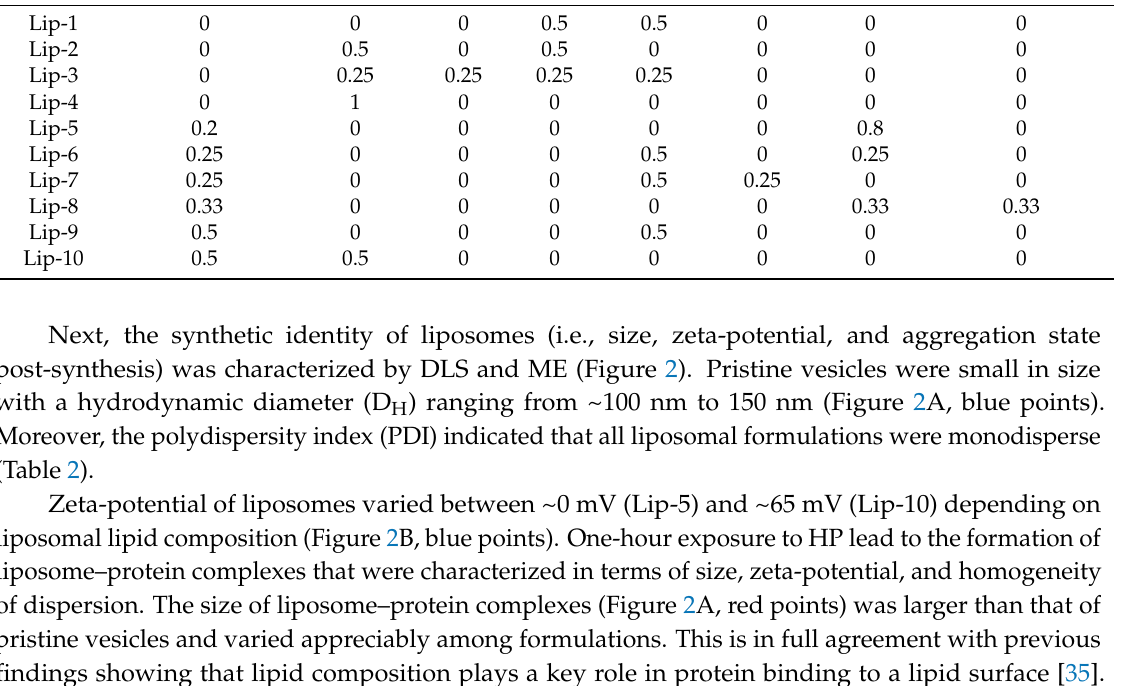
Table 1. The molar ratios of lipids used for synthesized a library of 10 liposomal formulations.